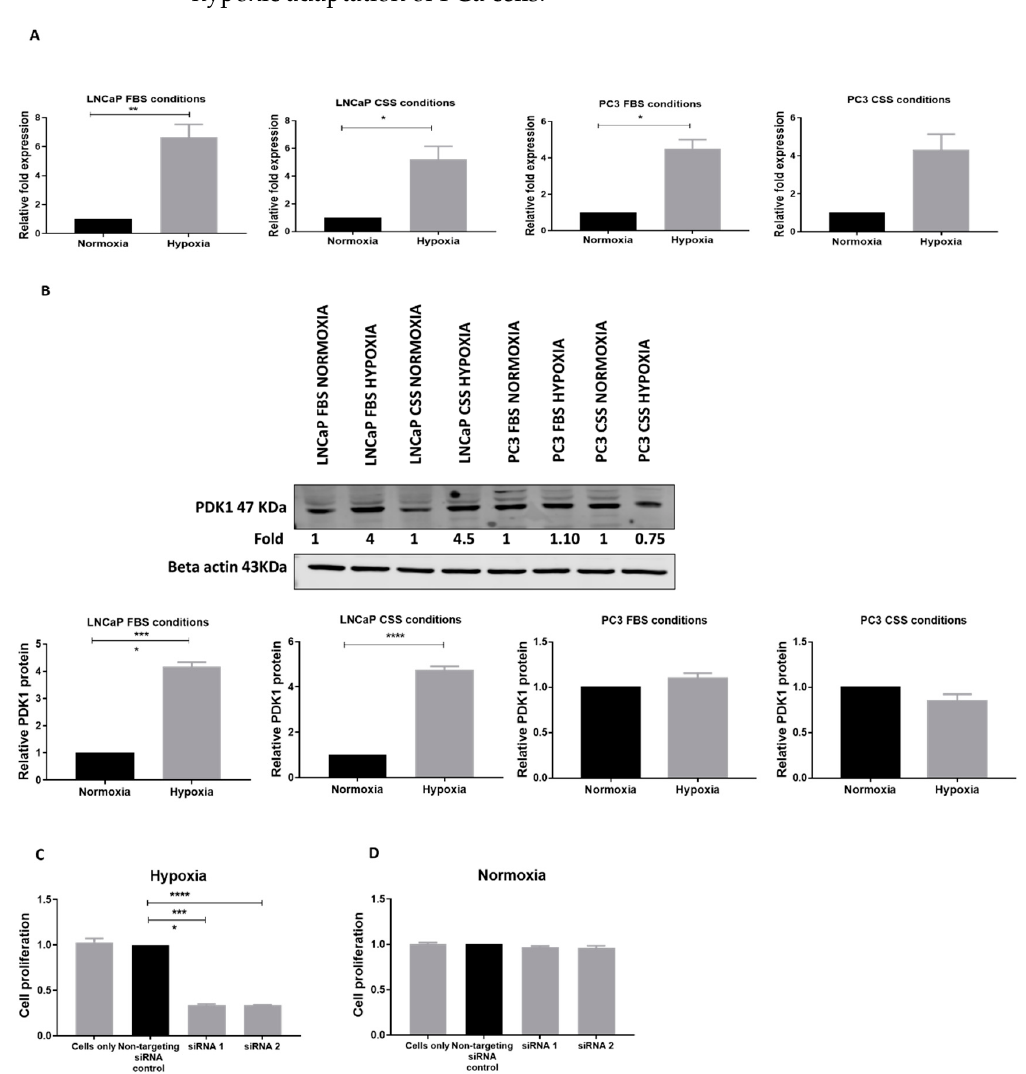
Figure 4. Hypoxia regulated PDK1 in prostate cancer cells. ( A ) PDK1 mRNA expression is significantly upregulated under hypoxic conditions in LNCaP in FBS and CSS conditions and in PC3 cells in FBS conditions. ( B ) PDK1 protein expression is upregulated under hypoxic conditions in LNCaP and no change in PC3 cells in both FBS and CSS conditions. ( C ) Sup- pression of PDK1 reduced the proliferation of LNCaP under hypoxic conditions. ( D ) Suppression of PDK1 did not affect the proliferation of LNCaP cells under normoxic conditions. The proliferation, as measured by the CyQuant assay, of each group was compared with the non-targeting siRNA control group. Statistically significant differences were assessed using an unpaired t-test ( A , B ), and one-way ANOVA with Tukey’s multiple comparison test ( C , D ); data presented are mean ± SEM, n = 3, **** p < 0.0001, ** p < 0.01, * p < 0.05. 2.5. miR-3916-3p and miR-3125 Directly Target the PDK1 rs1530865 miRSNP C Allele and miR-2116 Targets the PDK1 rs2357637 miRSNP A Allele Using Mirsnpscore and MicroSNiper computational prediction algorithms, we iden- tified that PDK1 rs1530865 and rs2357637 were predicted to affect the binding of four and two miRNAs, respectively. miR-3916, miR-877, miR-3928 and miR-3125 were predicted to target the PDK1 rs1530865 C allele, and miR-2116 and miR-889 were predicted to target the PDK1 rs2357637 miRSNP A allele (Figure 5A) (Supplementary Figure S4). To validate the miRNA–miRSNP interaction predictions, miRNA–SNP affinity was determined using reporter vector assays. The reporter gene assays showed that the co-transfection of miR-